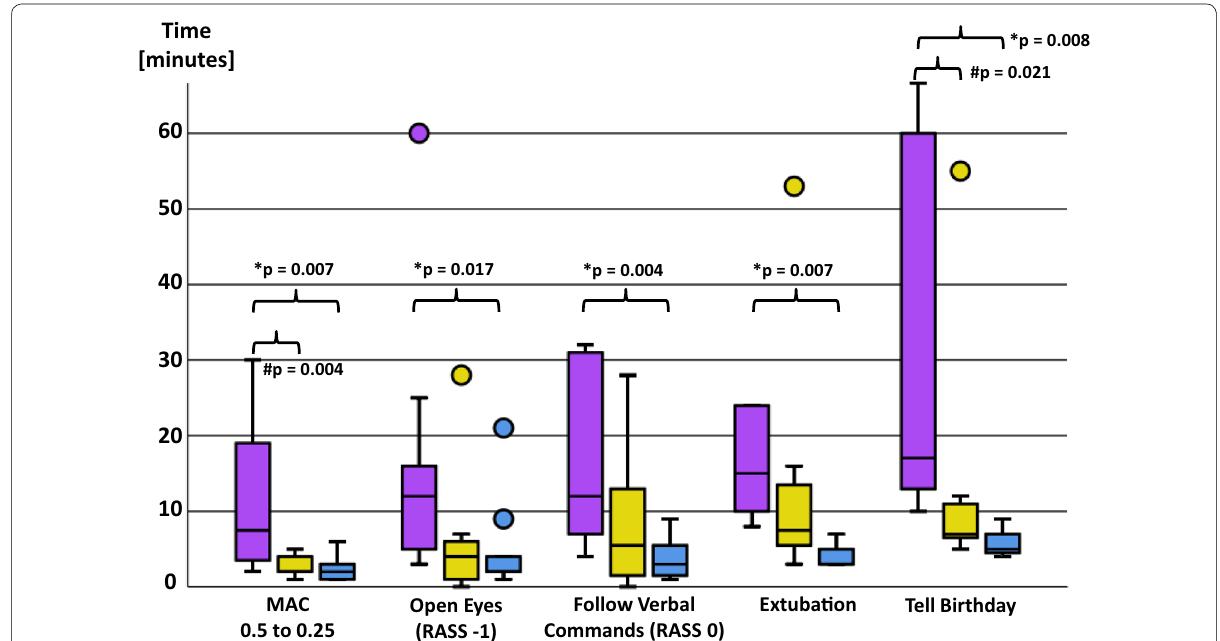
Fig. 2 Awakening times. The time needed to decrease the MAC from 0.5 to 0.25 was longest for ISO (pink box) and quickest for DES (blue box). Correspondingly, awakening was quickest after DES sedation, followed SEVO (yellow box) and ISO. Median (horizontal black lines), 1st and 3rd quantile (upper and lower end of the boxes), the 95% interval (horizontal black lines) and statistical outliers (circles: outside the 95% interval) are presented. *DES is significantly quicker than ISO; # SEVO is significantly quicker than